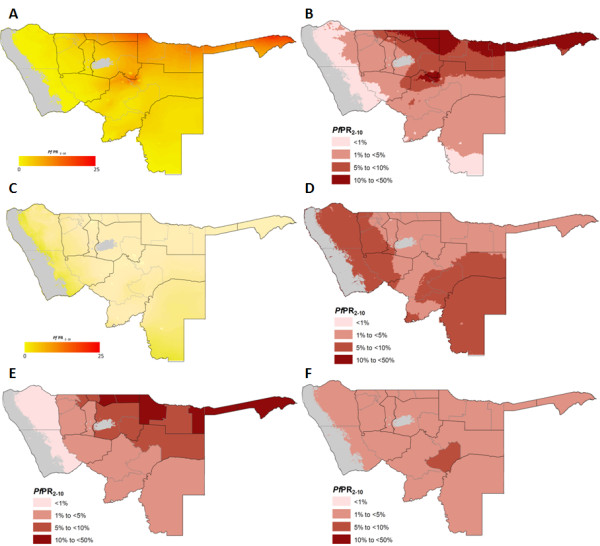
Maps of northern Namibia showing: A) The continuous maximum mean (receptive) PfPR2-10 at 5 x 5 km location from the posterior mean distribution of PfPR2-10 for the years 1969, 1974, 1979, 1984 and 1989; B) endemicity classes constructed from the PfPR2-10 continuous receptive risk map; C) the continuous posterior mean distribution of PfPR2-10 for 2009; D) endemicity classes constructed from the PfPR2-10 continuous 2009 risk map; E) PAPfPR2-10 receptive risks by health district; F) PAPfPR2-10 risks for 2009 by health district.